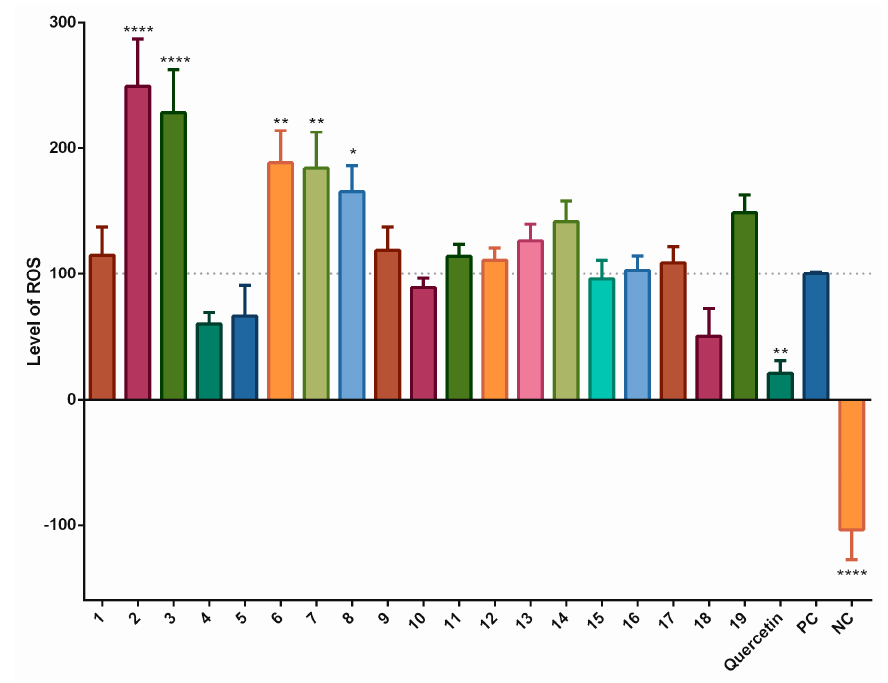
Figure 3. Antioxidant or pro ‐ oxidant effects of stilbenoids 1–19 (at a concentration of 2 μ M) on the formation of ROS after 24 h of incubation. In the THP ‐ 1 ‐ XBlue ‐ CD14 ‐ MD2 cell model, the formation of ROS was triggered by adding 100 μ M pyocyanin; quercetin was used as the standard (2 μ M), pyocyanin alone served as the positive control (PC; 100 μ M) and the vehicle alone was the negative control (NC). * = p < 0.05; ** = p < 0.01; and **** = p < 0.0001.